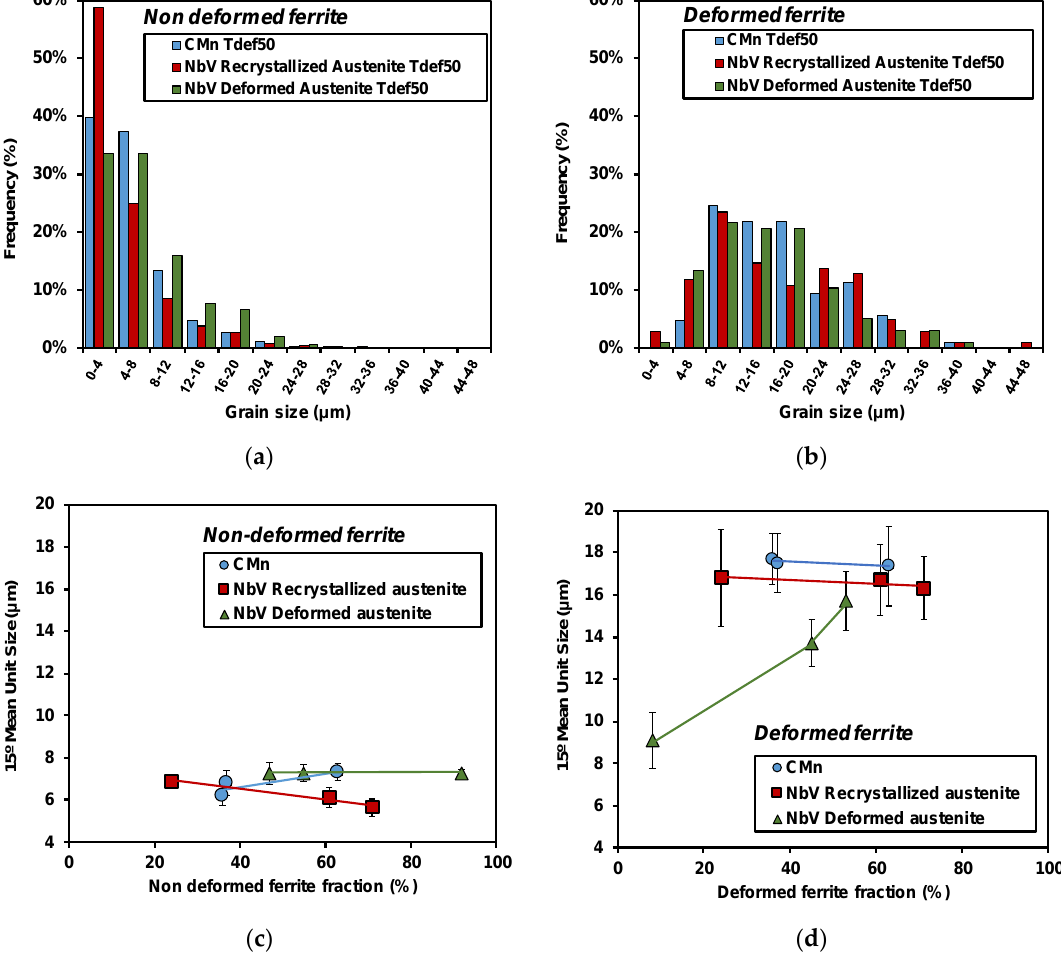
Figure 9. Grain size distributions corresponding to Tdef50 and different chemical composition (CMn, NbV recrystallized austenite, and NbV deformed austenite): ( a ) Non-deformed ferrite and ( b ) deformed ferrite population. Influence of austenite/ferrite balance, chemical composition, and austenite condition on 15° mean grain size of both ferrite populations: ( c ) non-deformed ferrite and ( d ) deformed ferrite population.